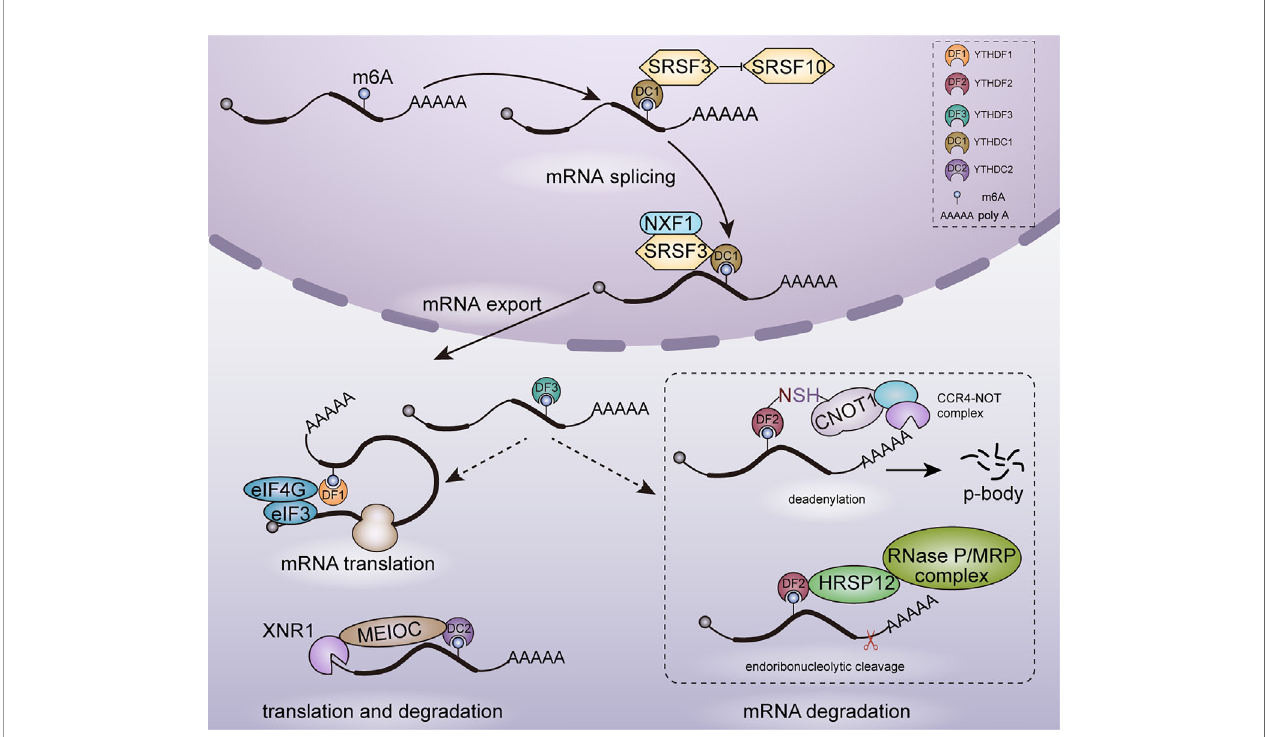
FIGURE 1 | Functions of YTH family proteins in mRNA metabolism. In nucleus, YTHDC1 participates in mRNA splicing and nuclear export. In cytoplasm, YTHDF1/2/3, YTHDC2 are involved in mRNAs translation and